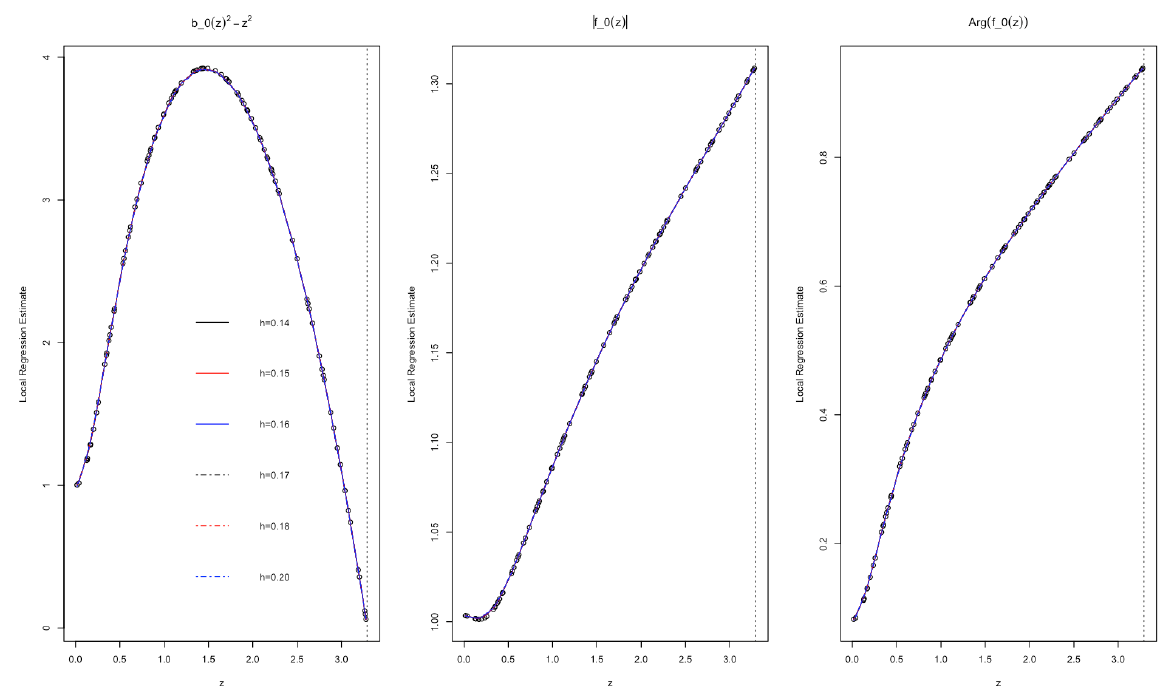
Figure 9. The estimates of critical collapse functions corresponding to a β solution of a hy- perbolic case based on a local regression method of order l = 1 with bandwidth parameters h = { 0.14,0.15,0.16,0.17,0.18,0.20 } based on a training sample of size n = 100.